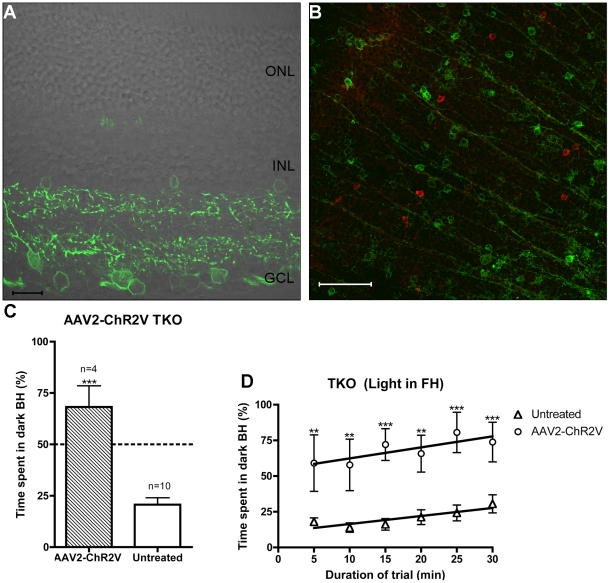
Channelrhodopsin-2 expression in the inner retina of TKO mice causes the induction of behavioural light aversion.(A) and (B) AAV2 transduced expression of Channelrhodopsin-2/Venus fusion (ChR2V) protein (green) in the ganglion cell layer of a TKO retina (AAV2-ChR2V TKO). (A) Transverse retinal section, ChR2V is visualised in many cells of the ganglion cell layer. Scale bar 20 µm (B) Immunohistochemistry on flat mount retina (focussing on the ganglion cell layer) for β-galactosidase (red) with ChR2V in green. Scale bar 100 µm. (C–D) Light aversion behaviour in the AAV2-ChR2V TKO. In these two graphs the comparison is between transduced and untreated animals when there is illumination in the front-half (FH). (C) Time spent in the dark back-half (BH) of the arena during the total 30 minutes of the trial. (D) Time spent in the dark (BH) of the arena over the course of the 30-minute trial. Stars (*) indicate significances (** p<0.01; *** p<0.001).